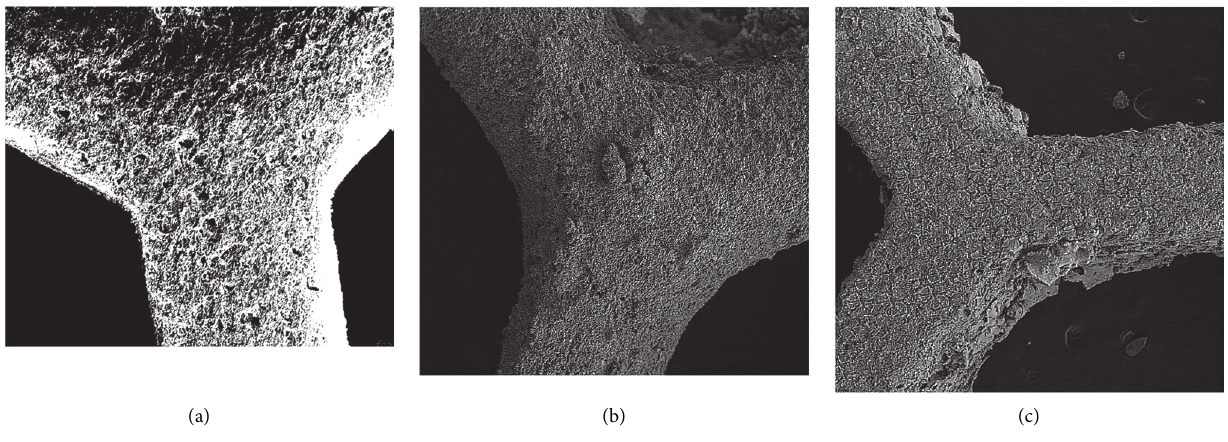
Figure 7: Structures of (a) COAT 1 and (b) COAT